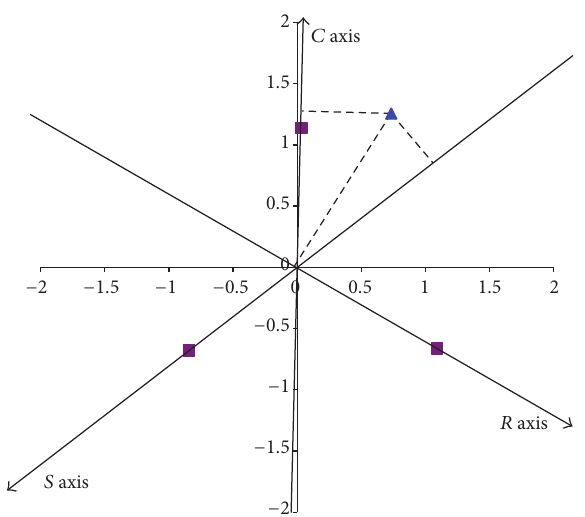
Figure 3: Converting the coordinates of Dactylis glomerata from principal component analysis ordination to 𝐶𝑆𝑅 coordinates (pro- jection of the species on 𝐶 , 𝑆 , and 𝑅